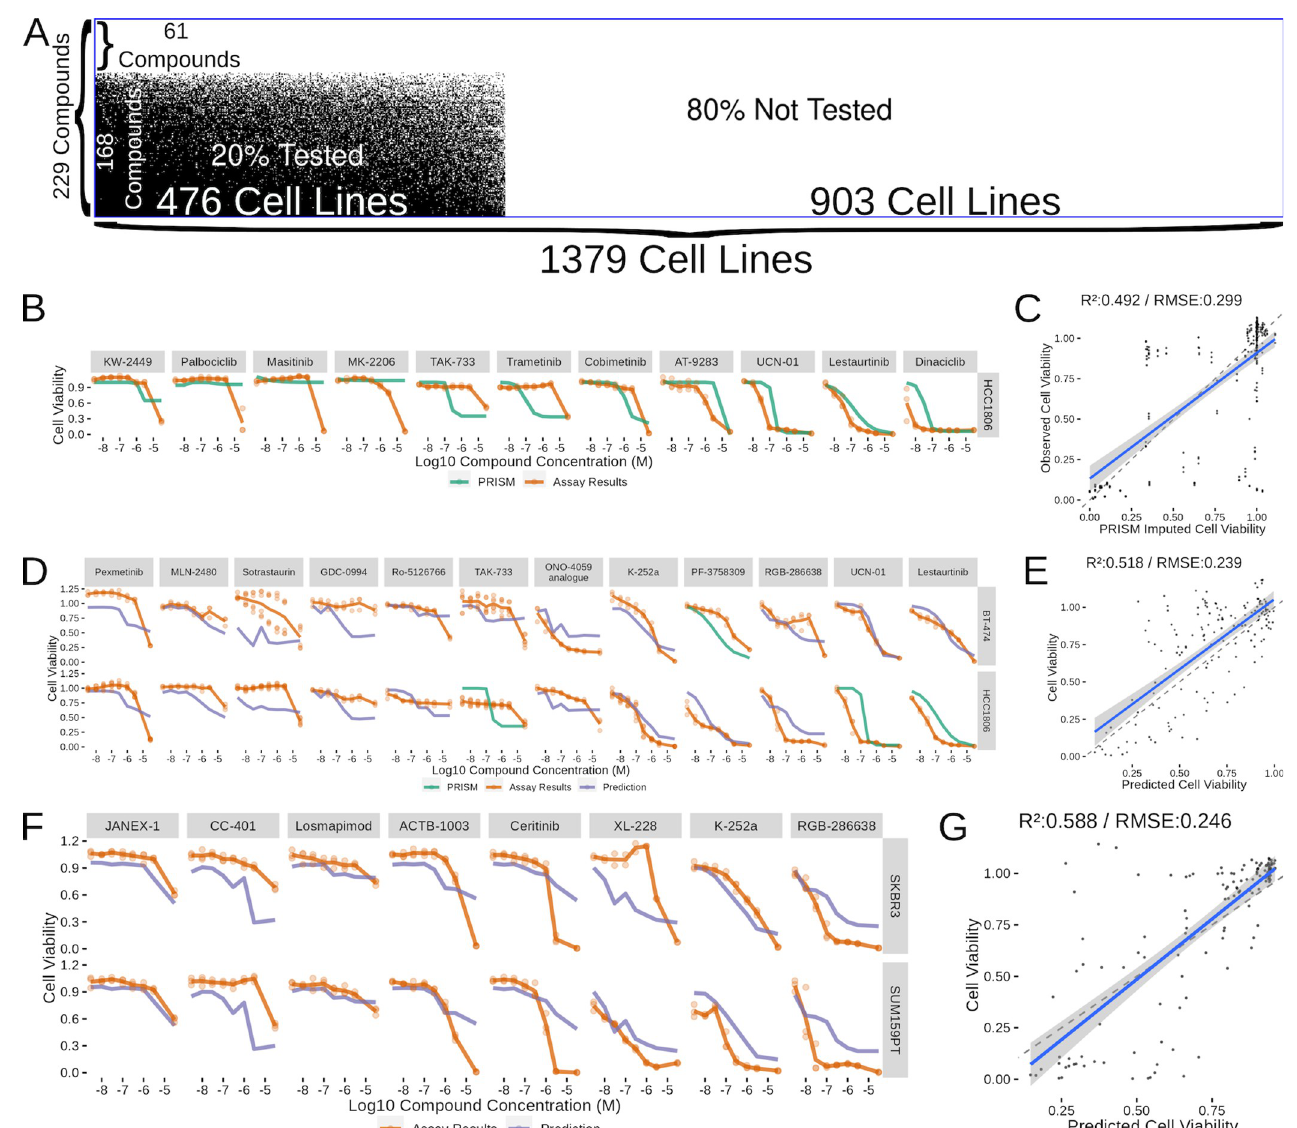
Fig 6. Validating a Subset of Compound Predictions in Breast Cancer Cell Lines. (A) Visualization of the space of compound (Y-axis) and cell line (X-axis) combinations that have been tested (white) and non tested (black) with a blue box surrounding the entire visualization. (B) Cell viability results from testing a set of compounds (labeled above each curve) and a cell line (HCC1806) already tested in the PRISM collection. (C) Scatterplot summarizing all the results from part B into a single plot with a linear best fit line showing in blue. (D) Cell viability results and corresponding predictions or PRISM results from a set of cell lines included in PRISM (BT-474 and HCC1806) and a selection of compounds which were mostly not included in PRISM. (E) Scatterplot summarizing all the prediction results from part D into a single plot. (F) Cell viability results and corresponding predictions for a set of cell lines and compounds not included in PRISM. (G) Scatterplot summarizing all the results from part F into a single